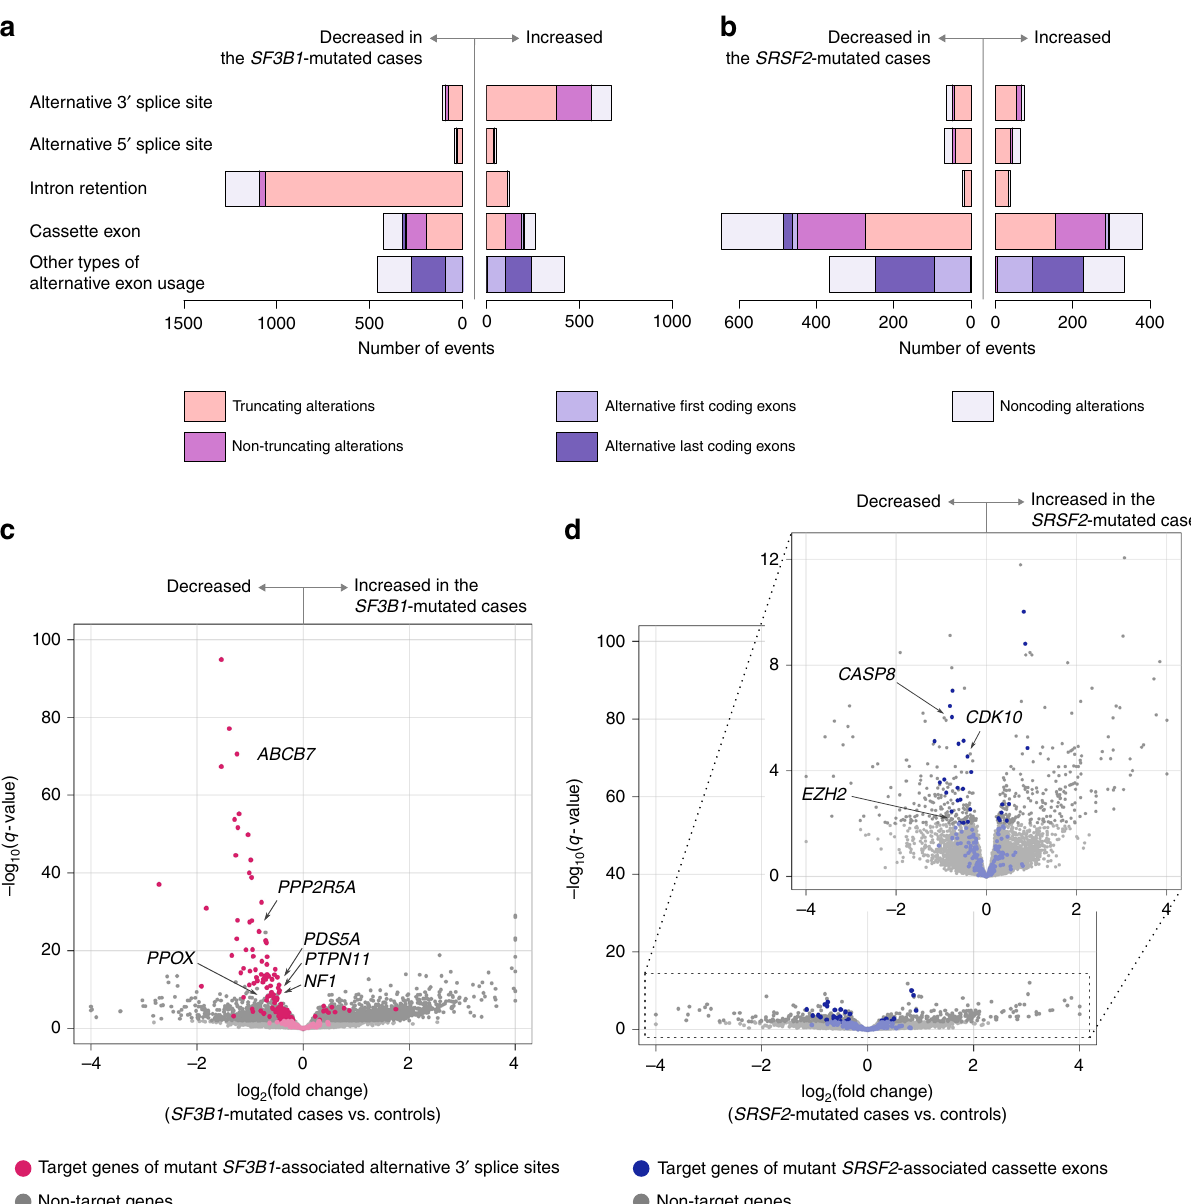
Fig. 3 Transcriptional consequences of splicing alterations. a , b Types and numbers of splicing alterations signi fi cantly associated with SF3B1 ( a ) and SRSF2 mutations ( b ). Bars in the right indicate alternative splicing events that were more frequently found in SF-mutated cases. Bars in the left are those that were more frequently found in the controls. Colors indicate consequences of splicing alterations at the transcript level. c , d Volcano plots comparing expression levels of the authentic transcripts between the SF3B1 - ( c ) and SRSF2 -mutated CD34 + cells ( d ) and those without known SF mutations. The number of samples in each group is shown in Fig. 1c. X -axis indicates fold changes in gene expression on a log 2 scale. Y -axis indicates q -values on a negative log 10 scale. Target genes of mutant SF3B1 -associated alternative 3 ′ splice sites are depicted in red ( c ). Those of mutant SRSF2 -associated cassette exons are depicted in blue ( d